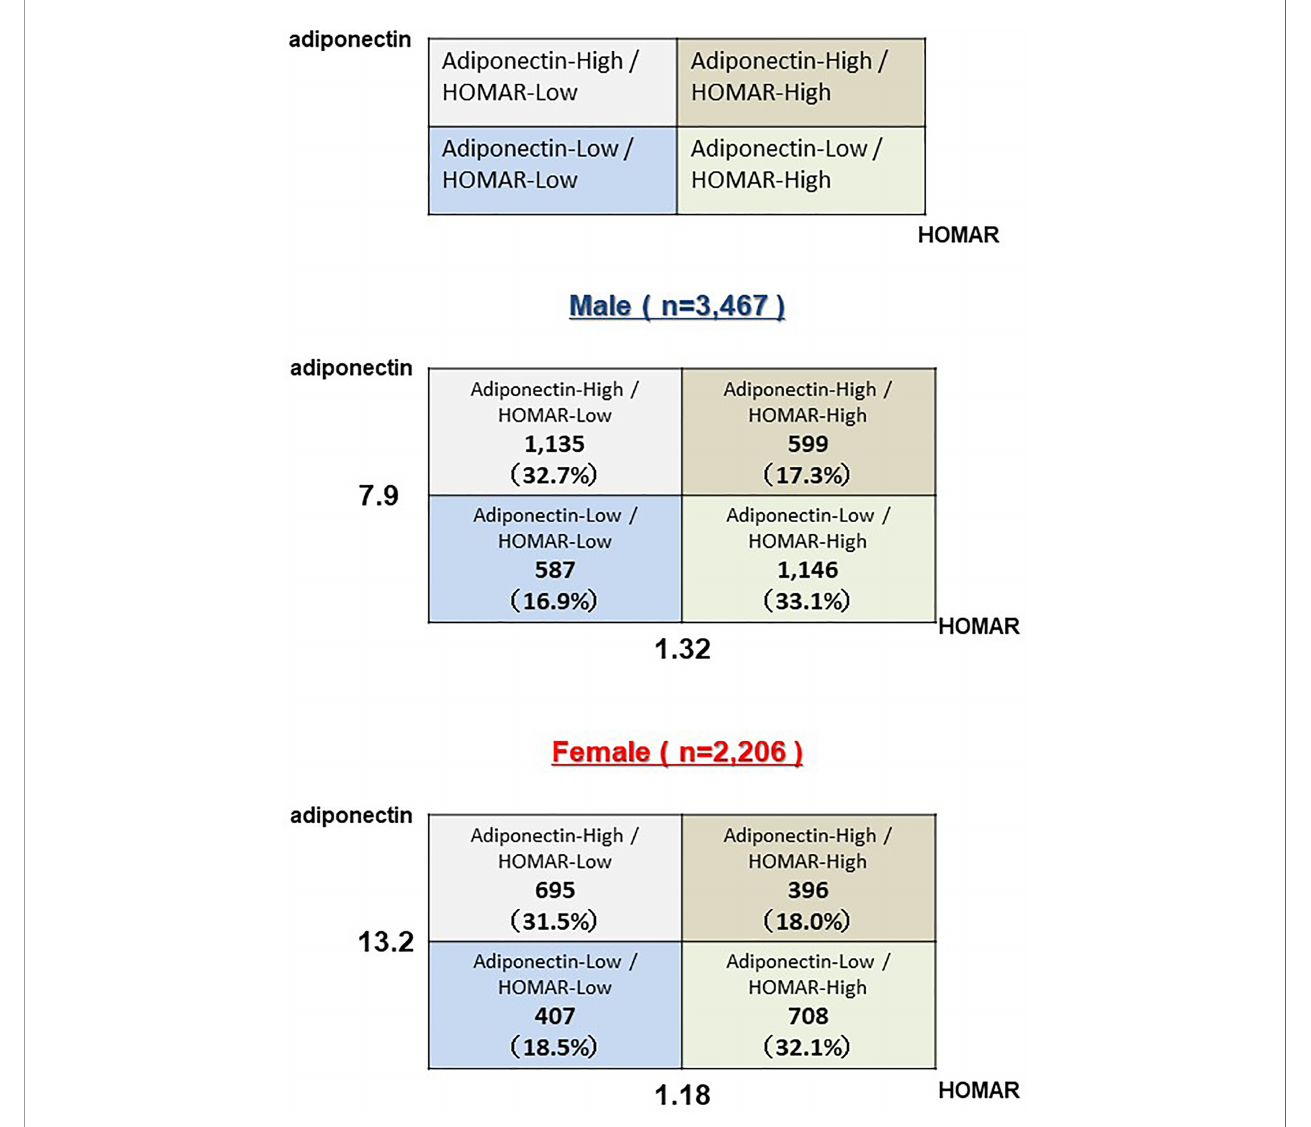
FIGURE 2 | Subjects above 60 years old were divided into four groups (H-adiponectin/H-HOMA, H-adiponectin/L-HOMA, L-adiponectin/H-HOMA, L-adiponectin/L- HOMA) by median adiponectin and HOMA-IR values and by